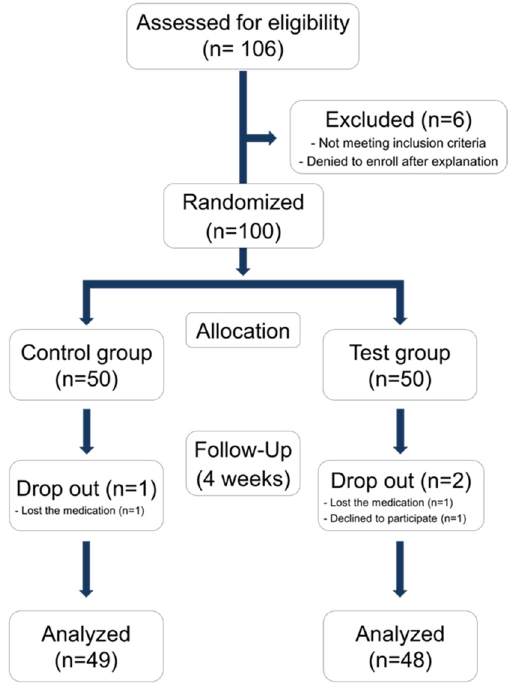
Figure 1. Flow chart of randomized clinical trial.